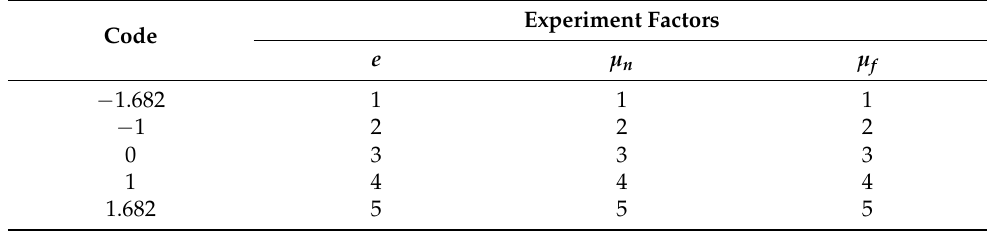
Table 3. Codes of simulation experiment factors.